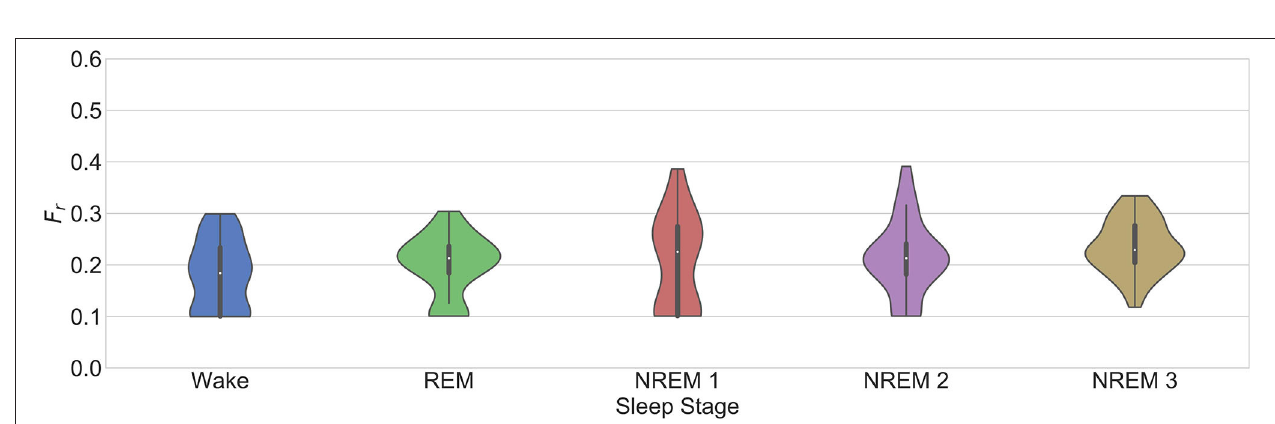
FIGURE 6 | Results in the dataset of segments during different sleep stages. Significant differences between the parameters are marked with *. Significant differences between sleep stages are marked with ⋆ .